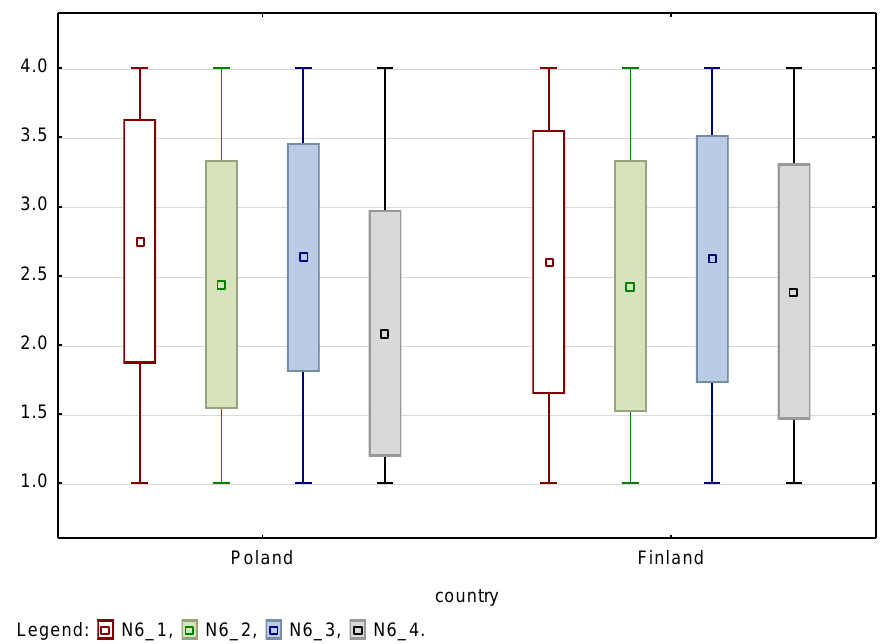
Figure 4. Box-and-whiskers plots for willingness to employ four types of PwD.